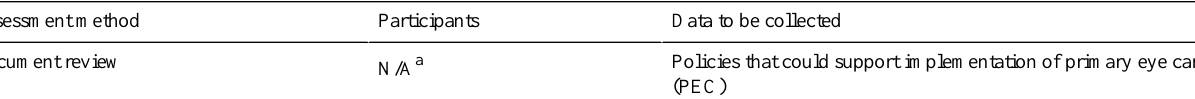
Table 2. Methods of assessment for technical capacities and participants.